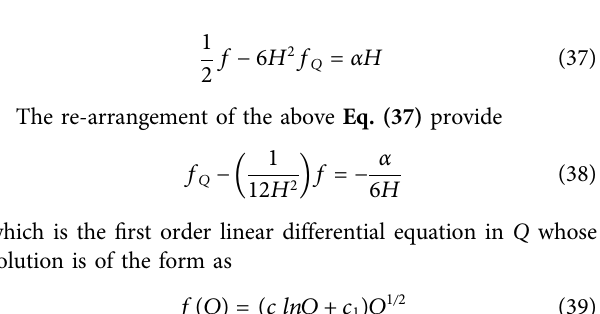
FIGURE 4 | Plot of the energy density of the reconstructed ghost dark energy f ( Q